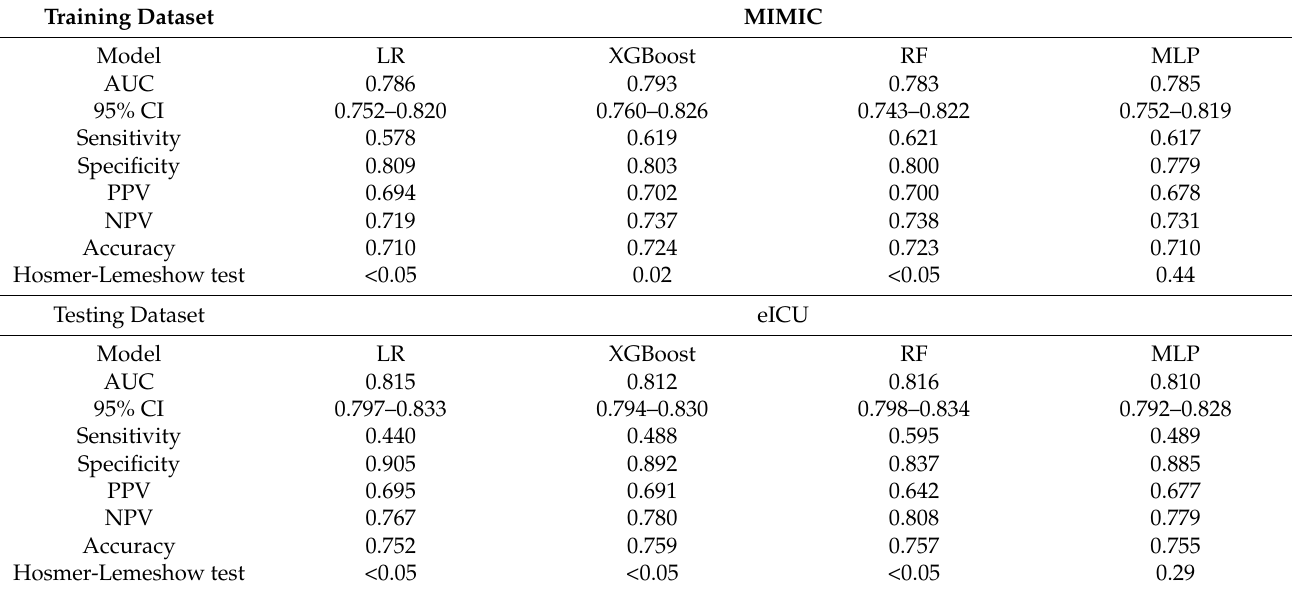
Table 3. Model performance measures in the MIMIC and eICU